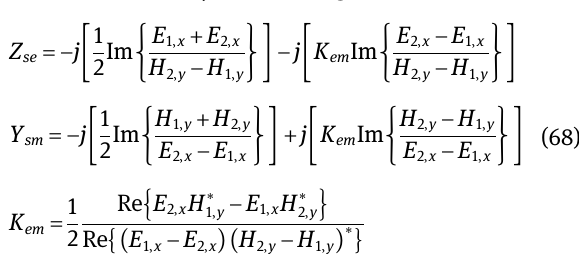
Figure 22: (Reprinted with permission from Ref. [56]). (a) A metasurface consisting of cascaded electric sheets placed perpendicular to the propagation axis within an over-moded cylindrical wave- guide. The metasurface comprises four electric sheets described by inhomoge- neous admittance pro fi les y n ( ρ ) . The sheets are separated by dielectric spacers of thickness d . The metasurfacedivides the waveguide into two outer regions (Region 1 & 5), and three inner regions (Region 2 and 4). (b) Simulated performance of the metasurface-based single mode converter with ideal electric admittance sheets using the 2D, axially symmetric fullwave solver COMSOL Multiphysics. A 2D surface plot of the real part of the electric fi eld for the metasurface-based single mode converter. (c) Realization of the capacitive sheets. Metallicringsare printedonboth sides of a thinsubstrate.Thebottomringsareshifted by a halfa cell with respectto the top